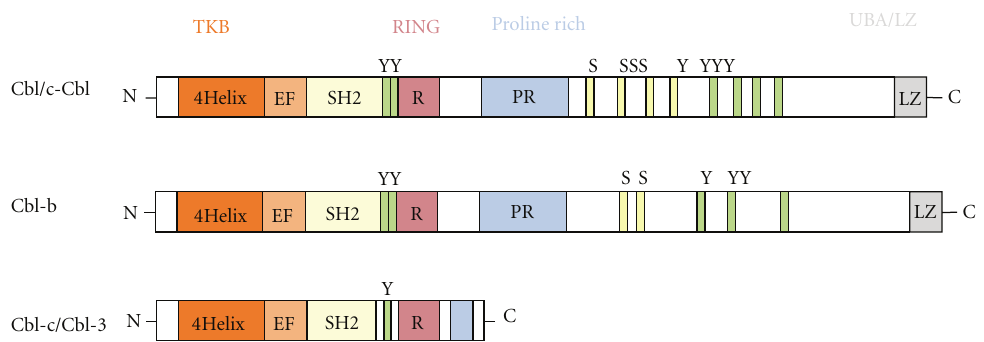
Figure 1: The mammalian Cbl protein family. Schematic representation of the domain architecture of the three mammalian Cbl isoforms, c- Cbl, Cbl-b, and Cbl-c/Cbl-3. The Cbl proteins are highly conserved in the N-terminal region where they comprise a tyrosine-kinase-binding domain (TKB), which is composed of a 4-helix bundle (4H), a calcium-binding EF domain, and a variant SH2 domain that is linked with the RING finger domain. The COOH-terminal region contains proline-rich stretches, multiple serine and tyrosine phosphorylation sites and a ubiquitin-associated UBA domain, and a leucine zipper. The Cbl-c isoform lacks the UBA domain and the leucine zipper domain. TKB, tyrosine-kinase-binding domain; 4H, four-helix bundle; EF, EF hand; SH2, Src-homology domain 2; R, RING “really interesting new gene” finger domain; PR, proline rich domain; Y, tyrosine residue; S, serine residue; LZ/UBA, leucine zipper/ubiquitin associated